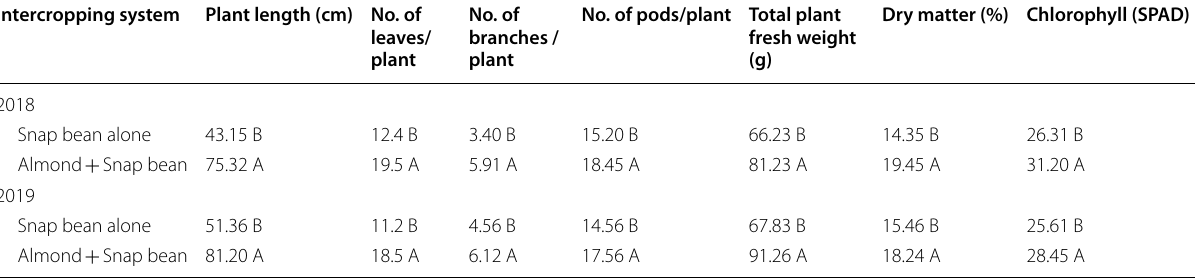
Values with diferent letter across the same row are signifcantly diferent ( p < 0.05)